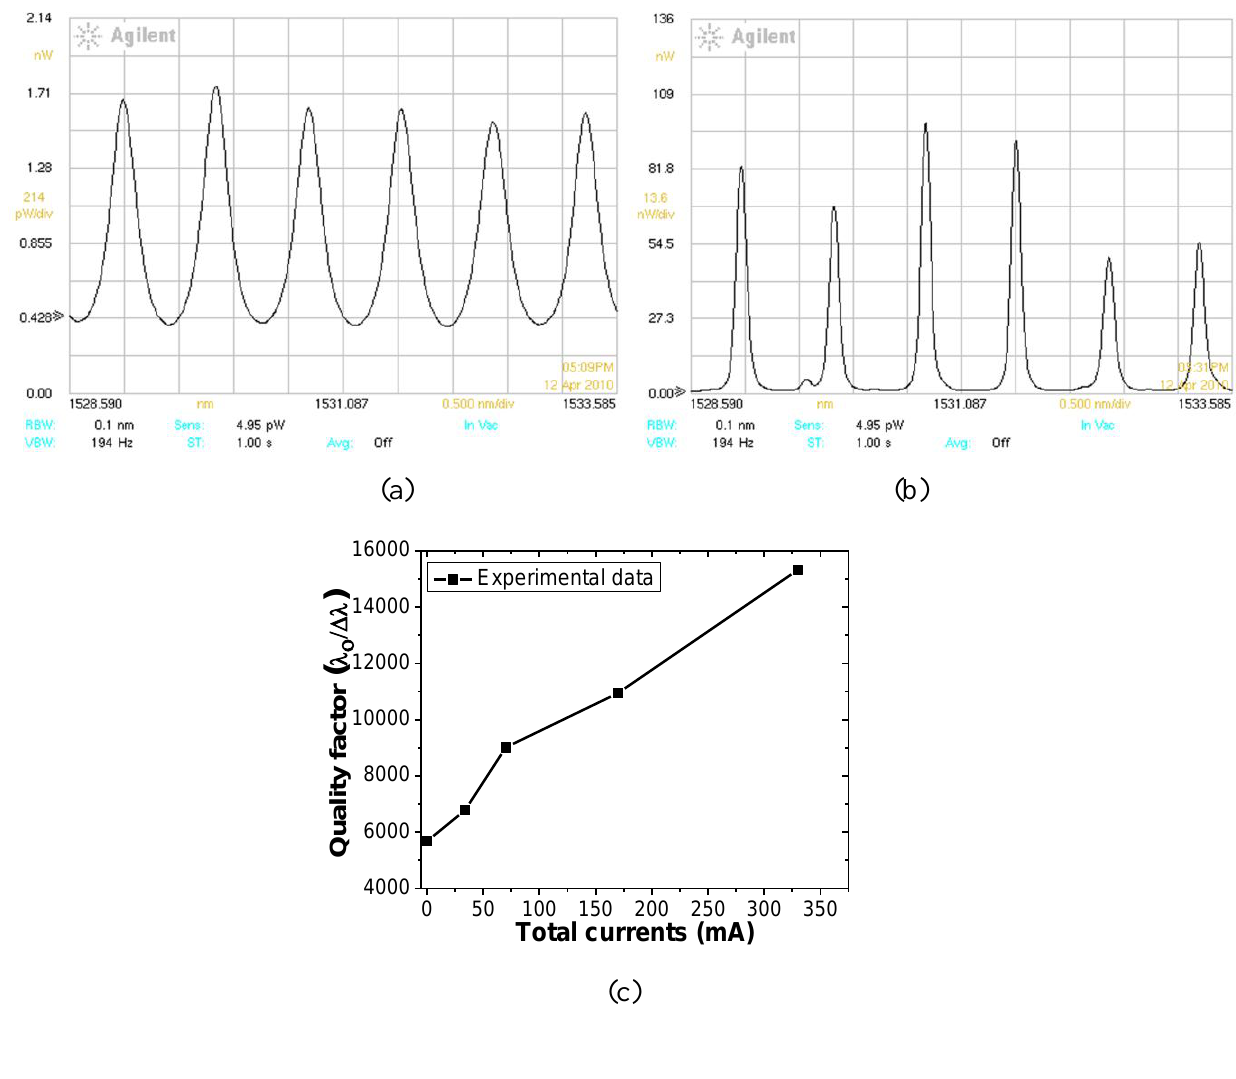
Figure 17. (a) Spectral response of a structure III type device with a total driving current G , and of 34 mA for G , G , G gain stages. (b) Spectral response of a structure III device 3 1 2 4 with a total driving current of 170mA for G , and G , G , G gain stages. (c) Measurement 3 1 2 4 of quality factor as a function of total driving current (  : peak wavelength,  : spectral o width of one peak at